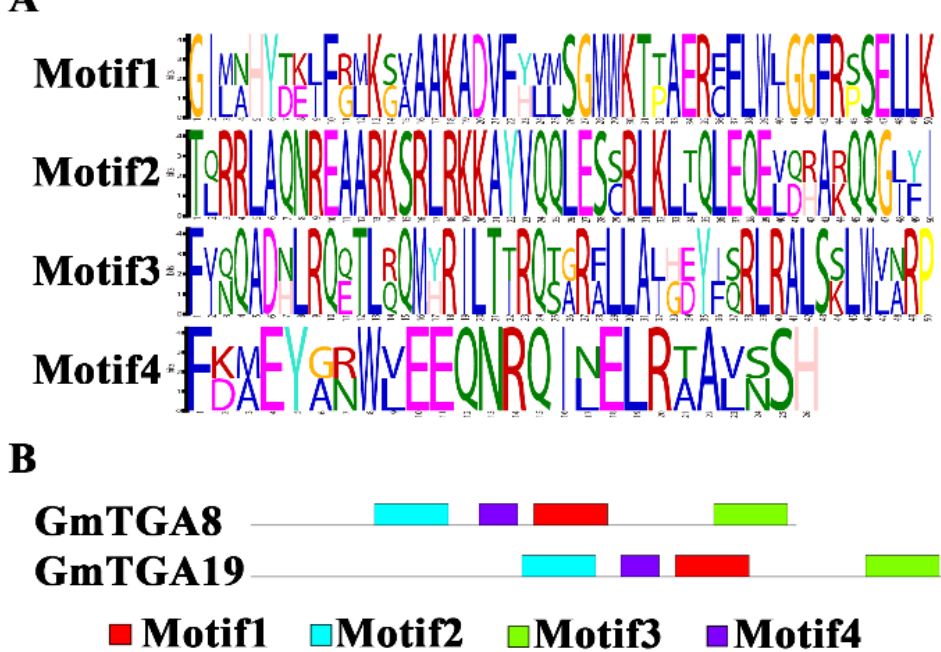
Figure 3. Conserved motifs in GmTGA 8 and 19 protein using MEME-suite. ( A ) The conserved motifs between GmTGA 8 and 19 proteins. The second motif covers the nuclear localization signals (NLS). Only the motifs with E -values < 0.05 as well as no overlap with each other were displayed. ( B ) The distribution of motifs along with the protein sequences. Gray lines represent the non- conserved sequences, and each motif is represented by a box numbered at the bottom.